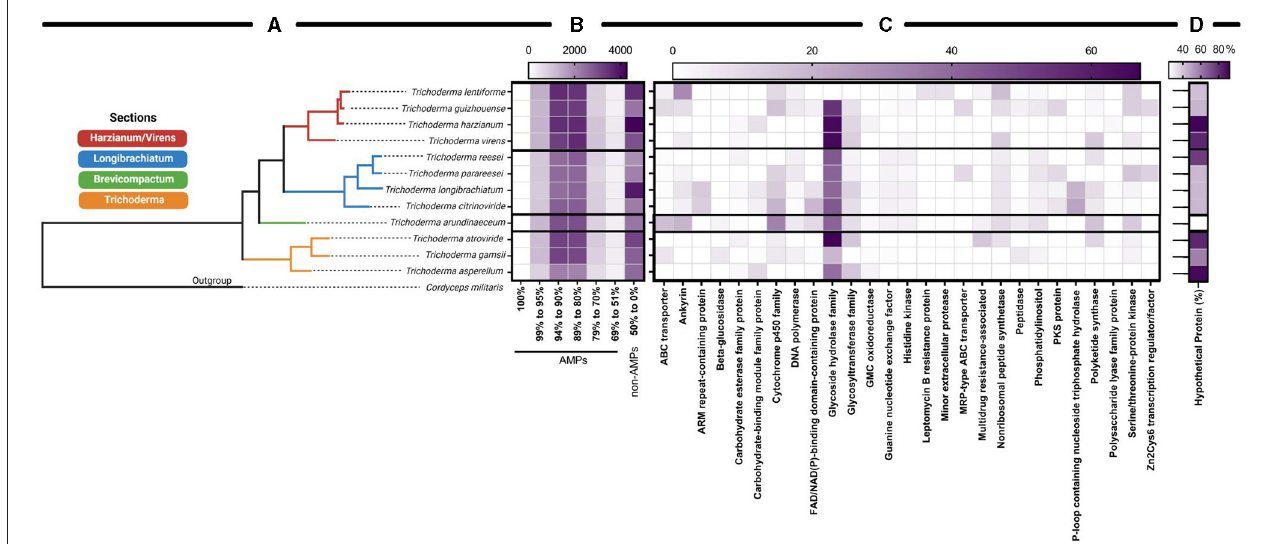
FIGURE 8 | Predictive AMPs found in available genomes of species in Trichoderma. (A) A dendrogram based on the genomes of Trichoderma spp. with reference protein sequences and (B) organized by their sections and the corresponding heat map showing the numbers having a 100, 99–95, 94–90, 89–80, 79–70, 69–51, and ≤ 50% match with AMP identifying characters shared by species of Trichoderma within their sections. (C) The top five annotated accession numbers found across all species from 95 to 100% match of AMPs. (D) Percentage of hypothetical proteins from 95 to 100% match of AMPs. The outgroup is Cordyceps militaris .